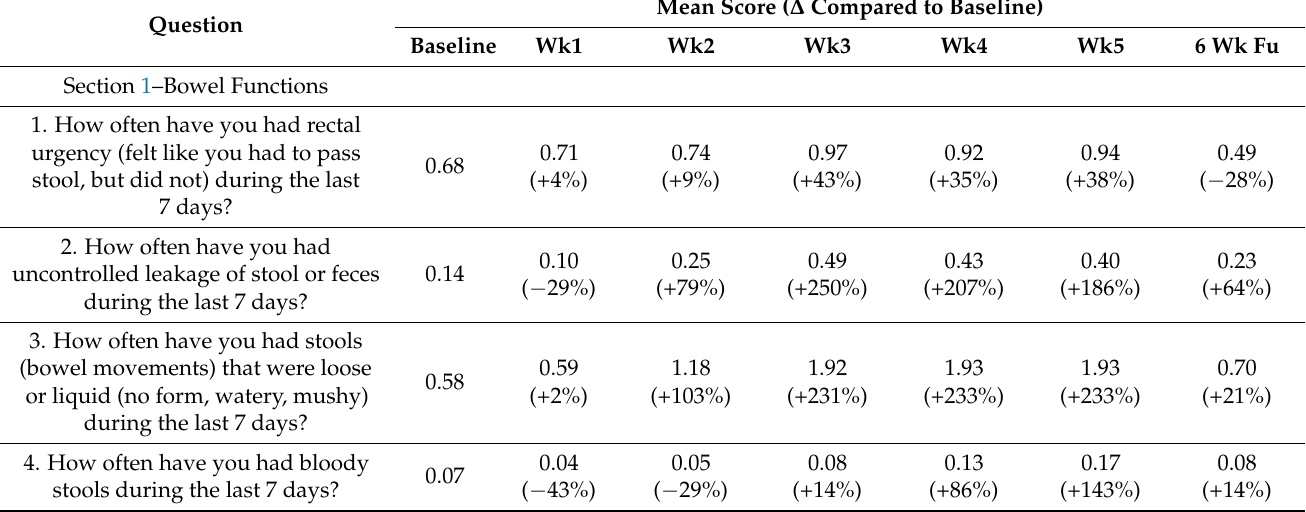
Table 2. Mean questionnaire